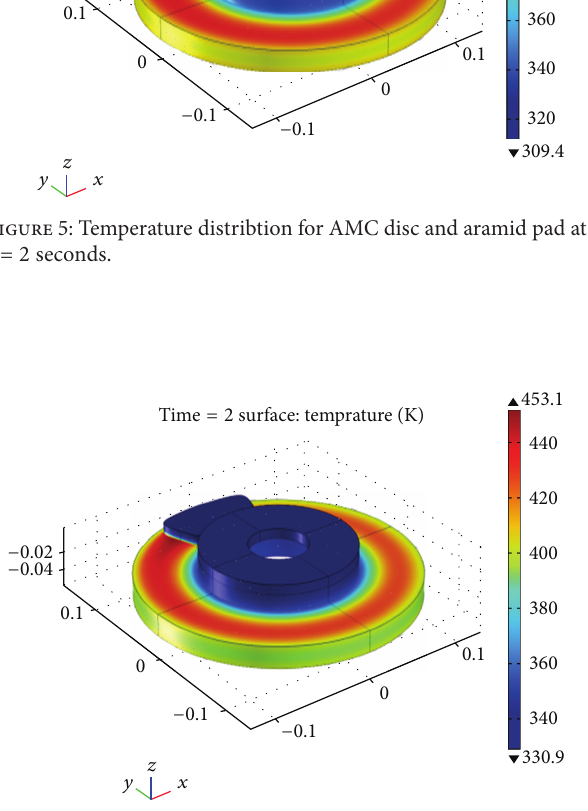
Figure 6: Temperature distribution for AMC disc and asbestos pad at 𝑡 = 2